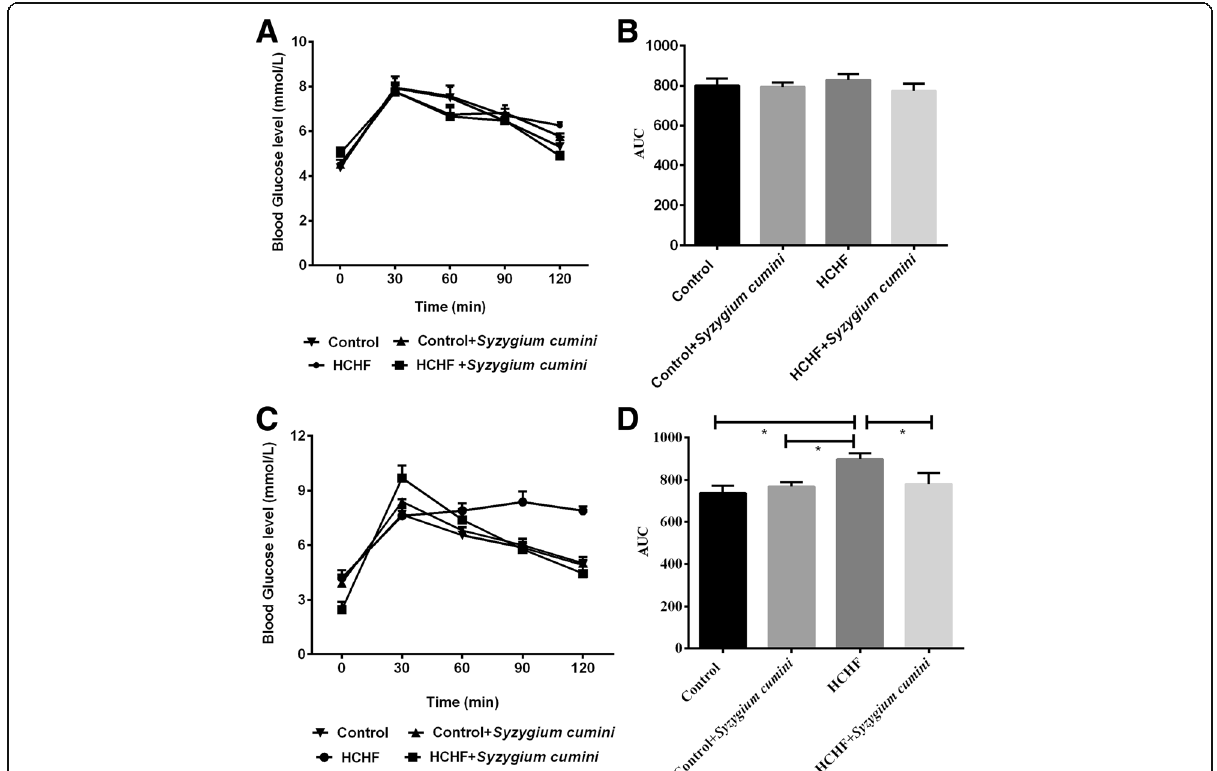
Fig. 3 Effect of Syzygium cumini seed powder supplementation on oral glucose tolerance test (OGTT) before and after the high fat high carbohydrate diet feeding in rats. a OGTT done at the beginning of the study and b is the corresponding area under the curve (AUC) values which showed no differences among the groups tested in the study. c OGTT done at the end of the study and d is the corresponding area under the curve (AUC) values which showed significant differences about glucose utilization among the groups tested in the study. Values are presented as mean ± SEM, n = 7. One way ANOVA followed by Newman-Keuls post hoc test were done for statistical comparison. Values are considered significance at p <